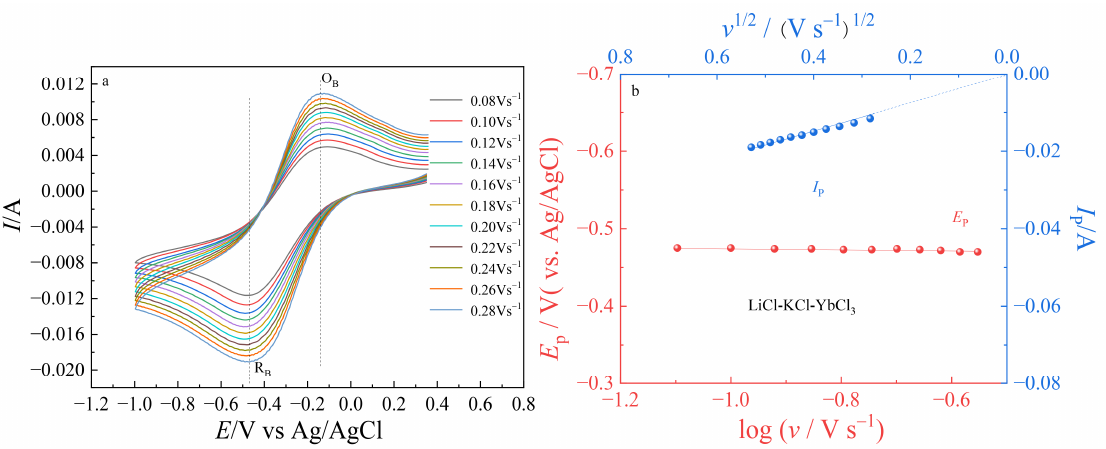
Figure 4. ( a ) CVs obtained on the W electrode at different scan rates in molten LiCl-KCl-YbCl 3 ; ( b ) peak potential of the cathodic R B vs. log v derived from ( a ); peak current of the cathodic R B vs. the square root of scan rate derived from ( a